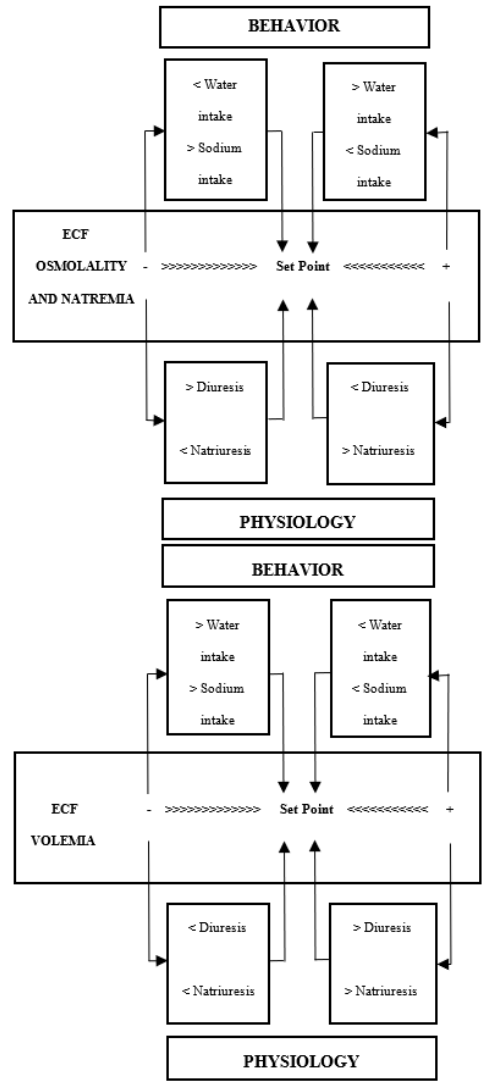
Figure 1. Behavioral and physiological mechanisms to maintain the osmolality/natremia ( upper ) and volemia ( lower ) of extracellular fluid (ECF) (from Mah í a and Bernal [7], with permission from